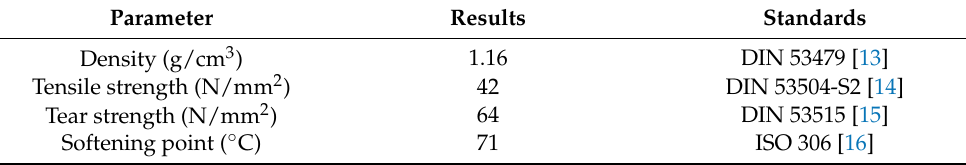
Table 3. Properties of WPU.